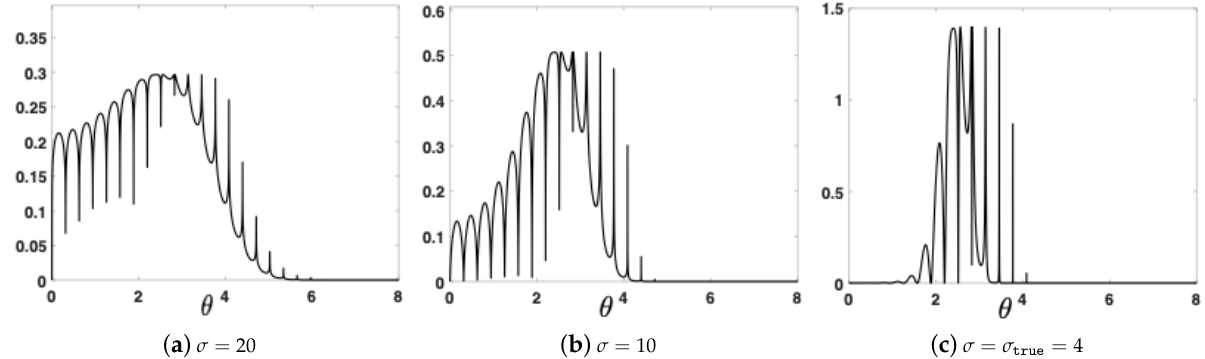
Figure 1. Conditional posteriors corresponding to different values of σ : ( a ) σ = 20, ( b ) σ = 10, and ( c ) σ = σ true = 4.